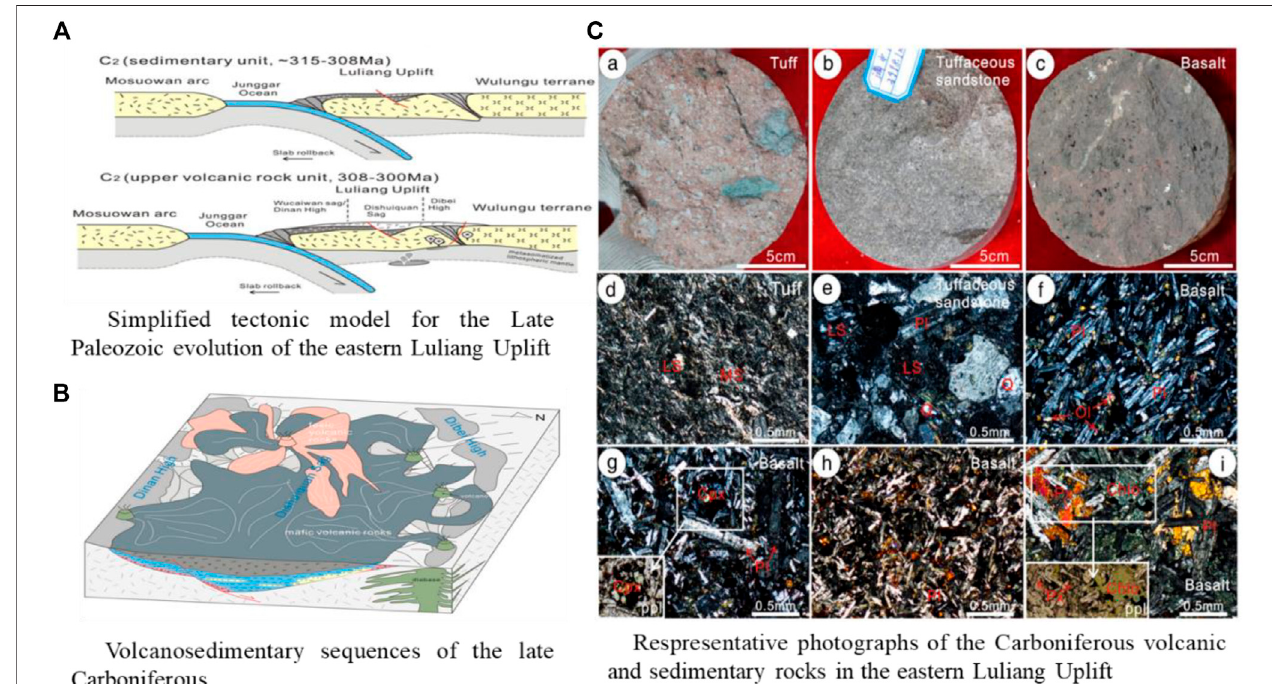
FIGURE 1 | Tectonic model, volcanosedimentary sequences and respresentative photographs of Carboniferous volcanic gas reservoir in Junggar Basin (Li et al., 2015a; Li et al., 2015b). (A) Simpli fi ed tectonic model for the Late Paleozoic evolution of the eastern Luliang Uplift. (B) Volcanosedimentary sequences of the